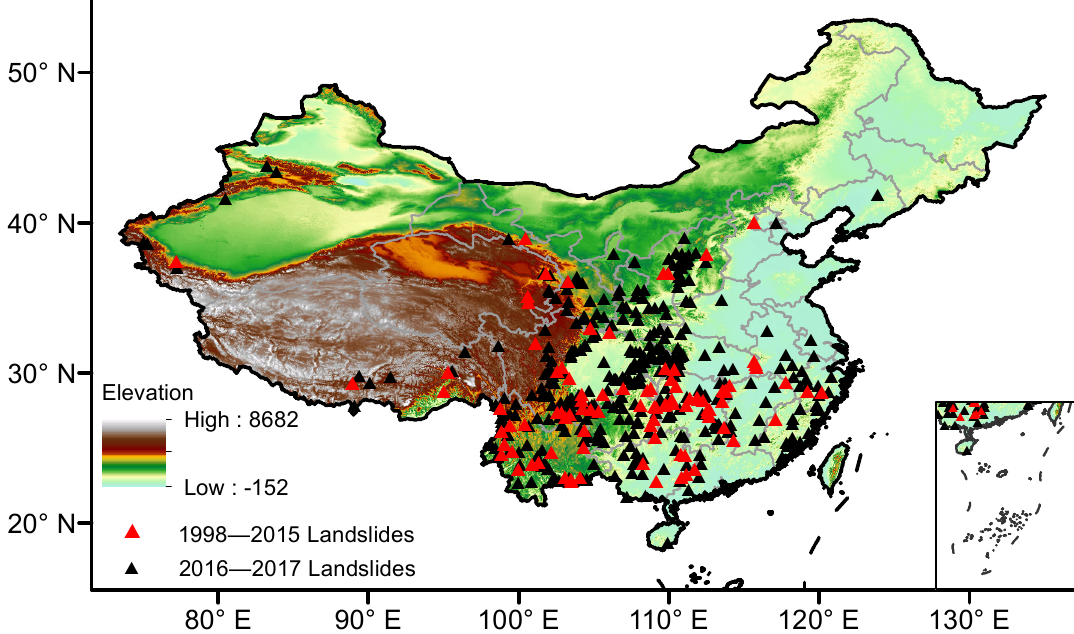
Figure 1. Location of landslides collected during 1998–2017 in China and the elevation (unit: m)